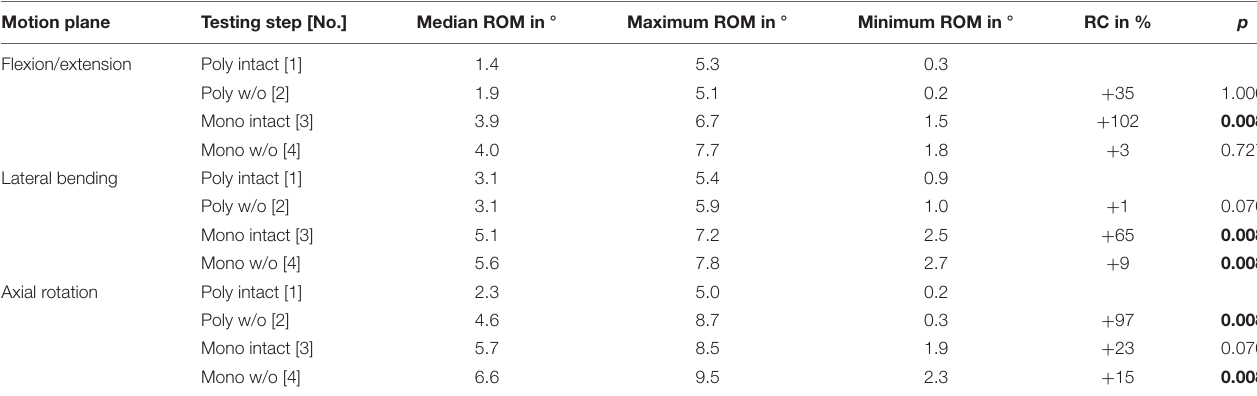
TABLE 6 | Results for T5-T6 range of motion at pure moments of ± 5 Nm ( n = 8) depending on primary motion plane and testing step. Motion plane Testing step